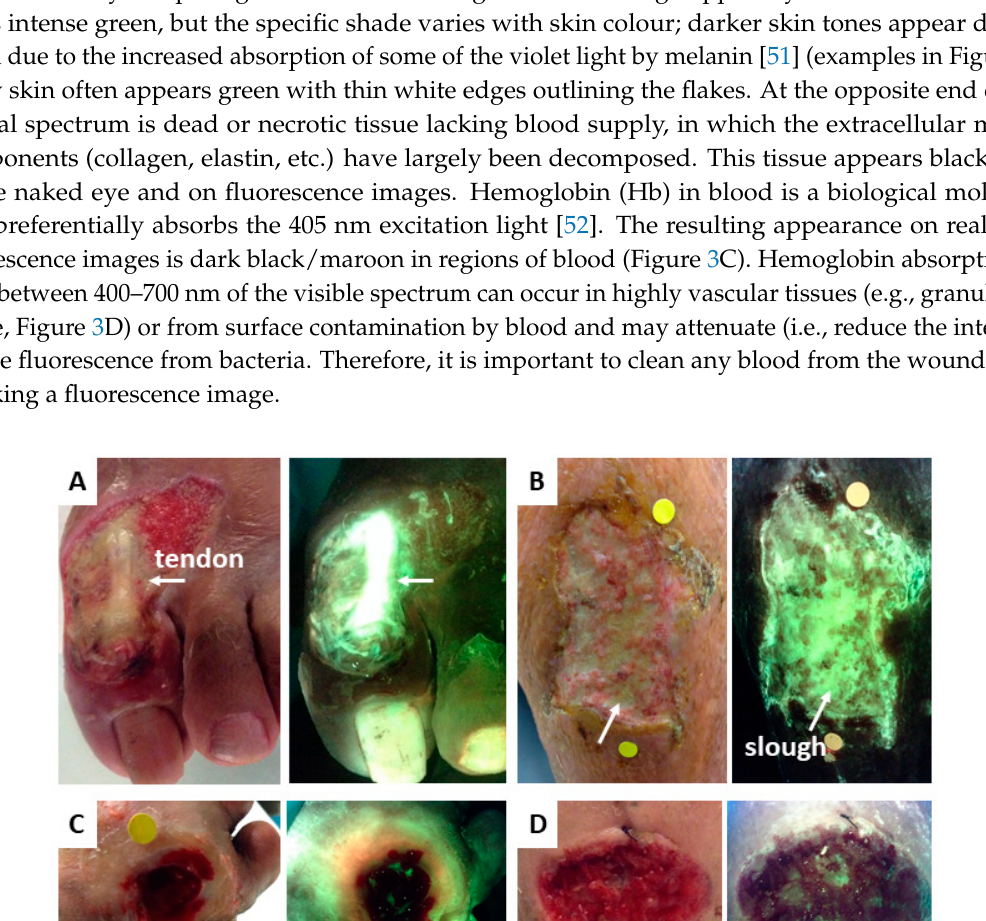
Figure 4. Variation in green fluorescence due to skin tone. ( A ) Lighter skin tones fluoresce a light green colour. As melanin concentration increases ( B , C ), the tone of green in the fluorescence images also darkens due to absorption of excitation light preferentially by melanin causing attenuation of the tissue fluorescence.